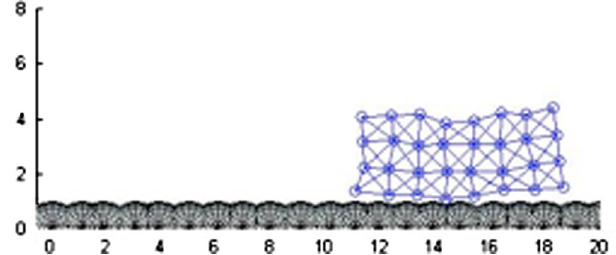
FIG. 1 (color online). Screen shot of the simulation students were building by using particle-spring systems to model an elastic object sliding over a rough surface. This model consists of 4 (cid:3) 8 mass particles connected with springs, up to eight springs for each particle. The springs are assigned damping in order to model the object with different elastic